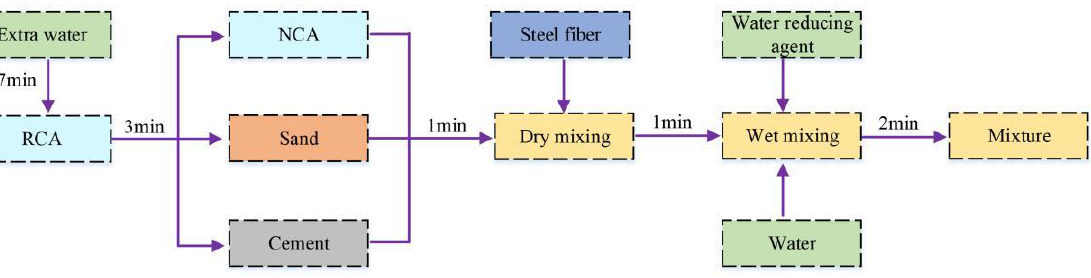
Figure 5. SFRC mixing process.